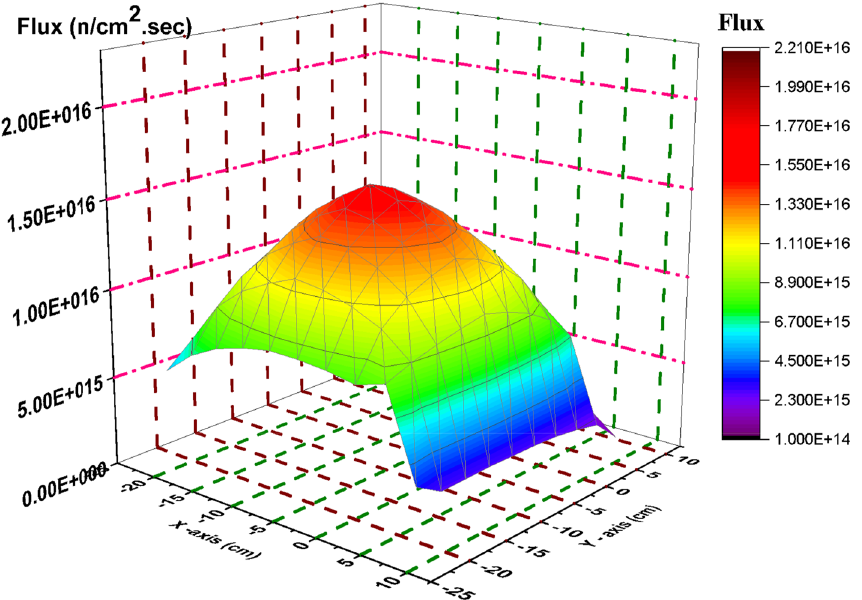
Figure 8. Total flux distribution for the four bundle using 10 meshes in case of B 4 C in the control